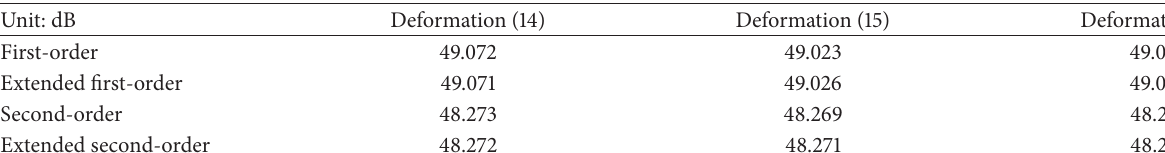
Table 2: Maximum directivity of each pattern.